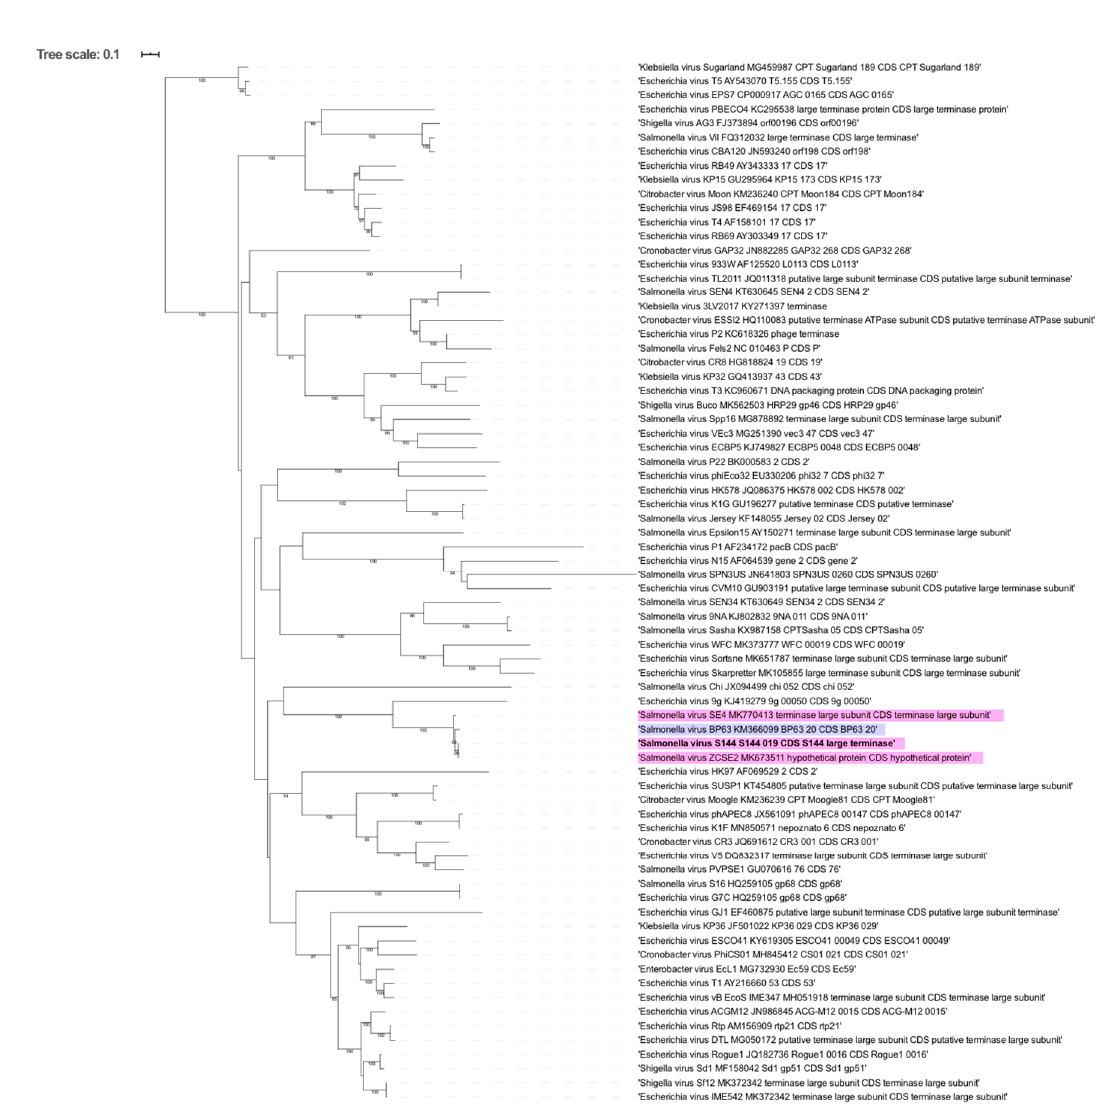
Figure A6. Maximum-likelihood phylogenetic trees based on amino acid sequences of ( a ) major capsid protein, ( b ) DNA polymerase, ( c ) portal protein, ( d ) large subunits of terminase of phages from S144, its closest relatives ( Loughboroughvirus highlighted in pink and Rosemountvirus in purple) and all the phages where the gene was clearly annotated among the 93 representatives for each genus infecting Enterobacteriaceae . Phage names, accession numbers and gene names were adopted from GenBank. Bootstrap values higher than 50% are indicated at the branching points.